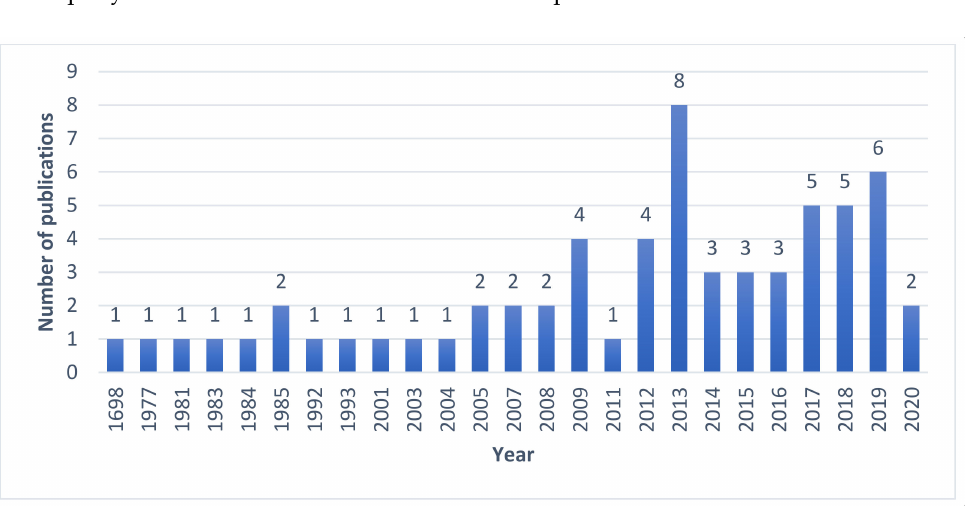
Figure 2. Number of publications per year.